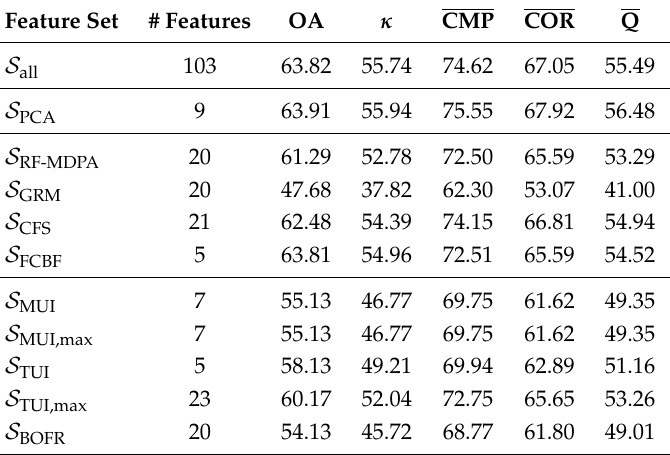
Table 3. Classification results (in %) derived with the Random Forest (RF) classifier for the Pavia University dataset (9